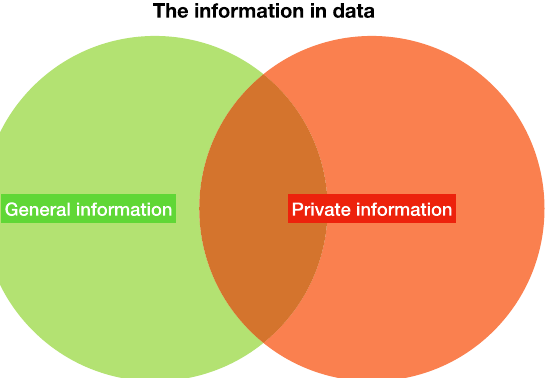
Figure 2. Information in data under the view of differential privacy. In a DP context, general information is that of the entire population in the data. On the other hand, private information is specific to a particular data